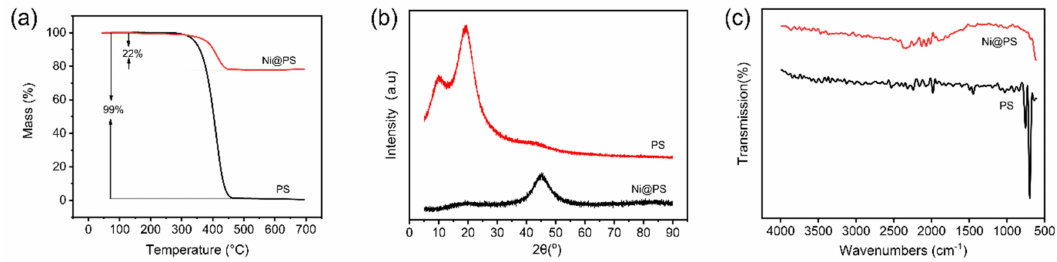
Figure 3. ( a ) TG curves, ( b ) XRD spectra, and ( c ) FTIR spectra of original PS and Ni@PS